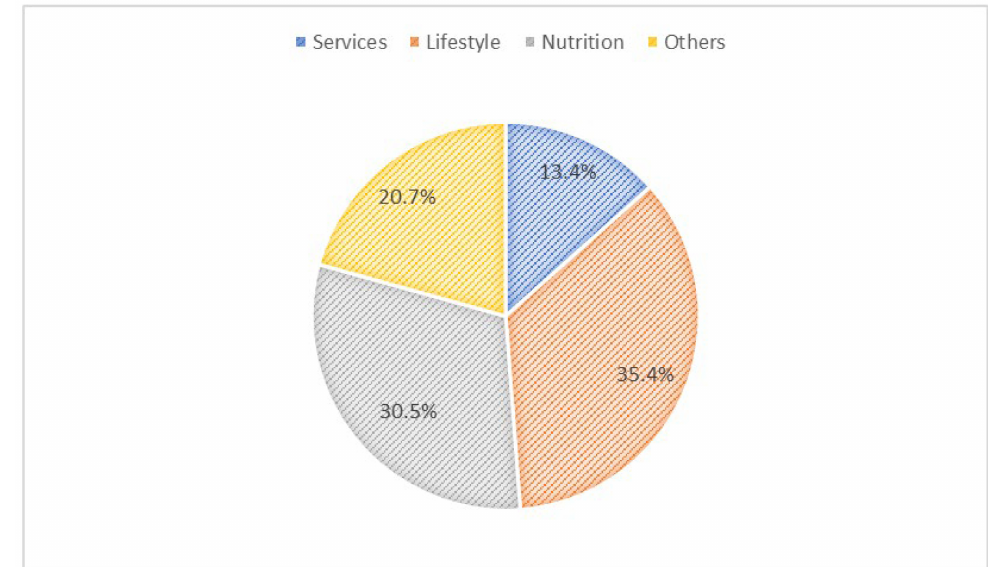
Figure 1. Main purposes of mHealth